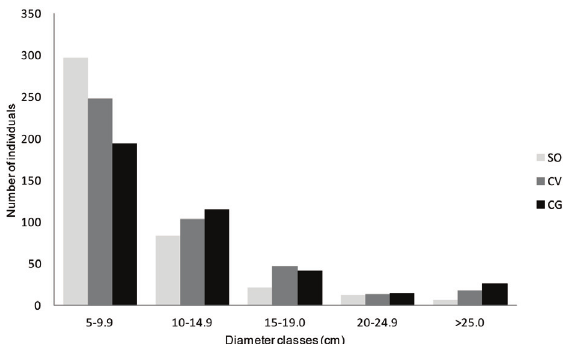
Figure 5 - Distribution of the number of individuals with DBH ≥ 5 cm per diameter classes in the burnt forest fragments Sooretama (SO, 14-yrs after fire, n= 1354 ind.ha -1 ), Córrego do Veado (CV, 25-yrs after fire, n= 1379 ind.ha -1 ) and Córrego Grande (CG, 25-yrs after fire, n= 1261 ind.ha -1 ), ES,